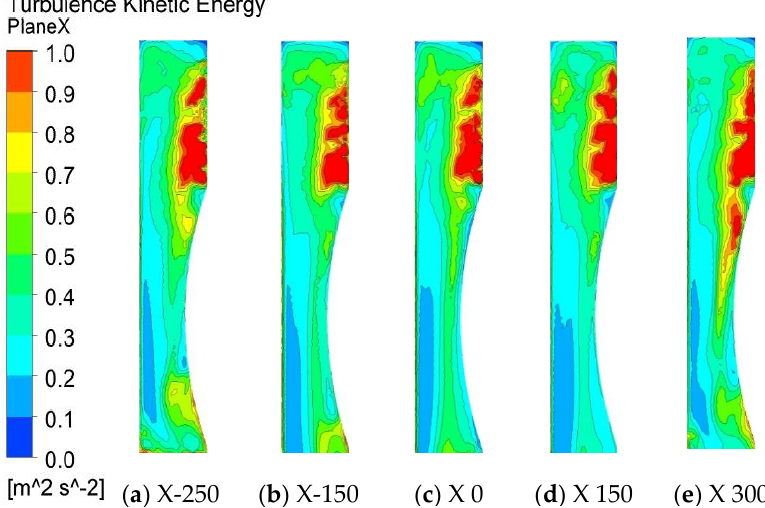
Figure 11. Flow diagram of the X-directional cross-section within the initial optimized head duct of the integrated stove.